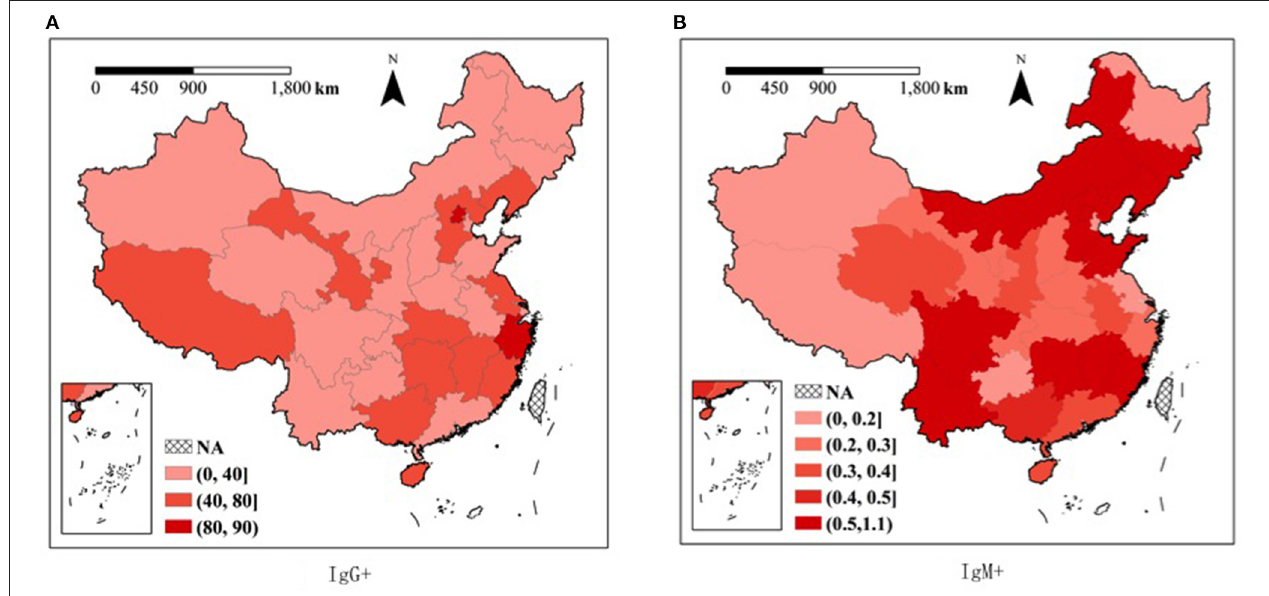
FIGURE 1 | Cytomegalovirus serology by provinces in China. (A) CMV IgG; (B) CMV